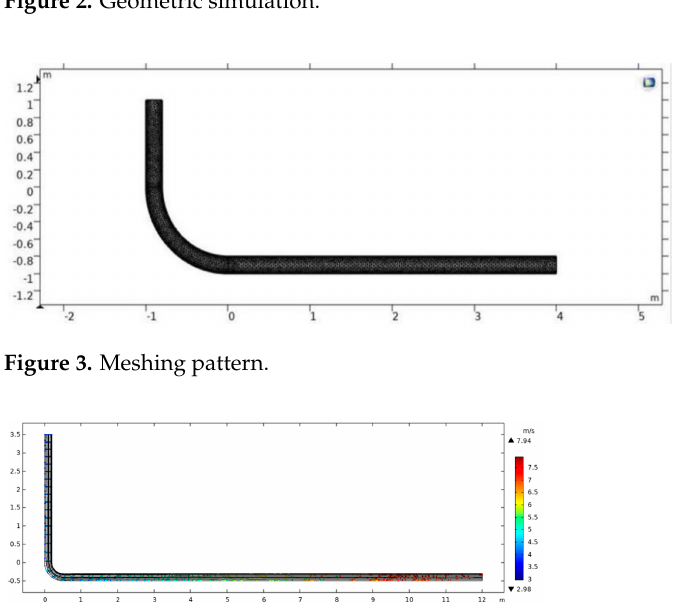
Figure 4. A contour of the flow pattern of particle